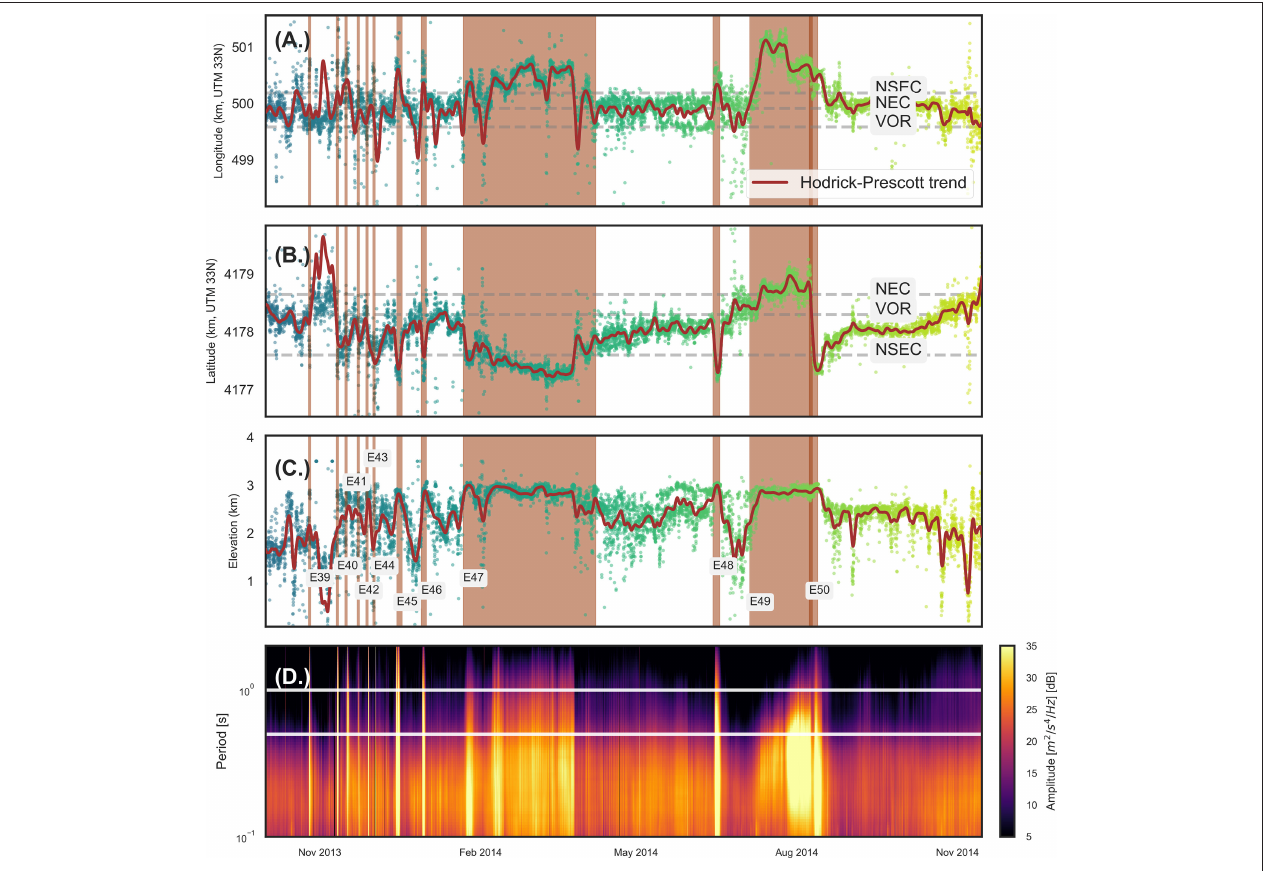
FIGURE 6 | Variation in time of the location of the volcanic tremor centroids ( A ; longitude in UTM33N, B ; latitude in UTM 33N, C ; Elevation above sea level). The color of the plots evolves with time, the red line is the corresponding Hodrick Prescott trend with a smoothing parameter of 10,000 ( Hodrick and Prescott, 1981, 1997). The orange vertical lines and zones refer to paroxysms reported in Table 1 and are characterized by short-lived explosive activity (vertical lines) until E45, when the activity changed into more effusive and longer. The horizontal dashed lines are the locations of volcano summit craters (NEC; North-East Crater; NSEC, New South-East Crater; VOR, Voragine). All three craters are within 500m in longitude. Spectrogram of the vertical component of station ECPN (D) . The white frame is the frequency band used in this